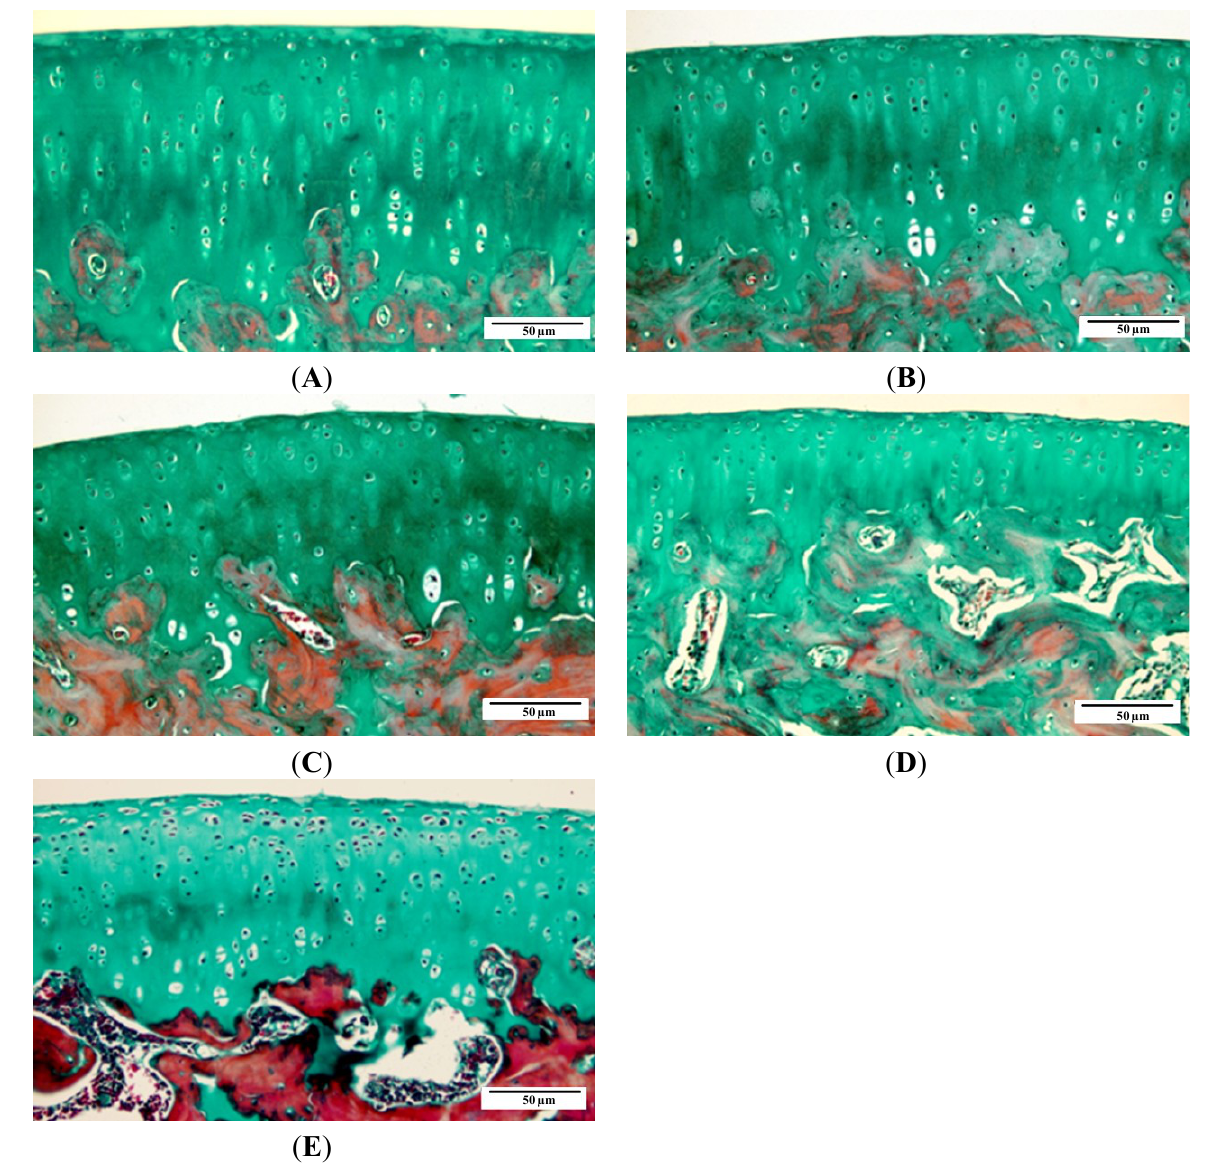
Figure 2. Histological findings of articular cartilage at distal femur. Representative sections are shown for each (×200). ( A ) 1-month group; ( B ) 3-month group; ( C ) 6-month group; ( D ) 9-month group; and ( E ) 12-month